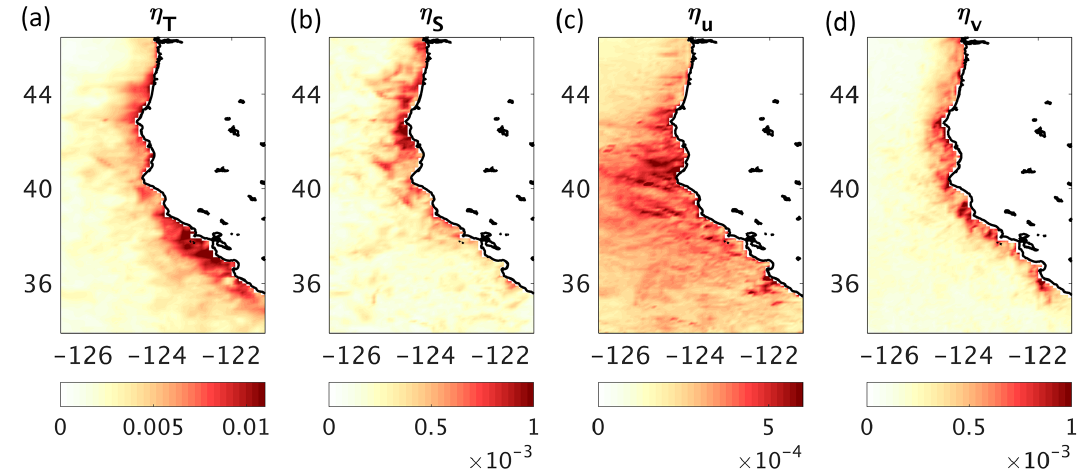
Figure 15. The rms corrections η made by weak constraint 4D-Var per time step during experiment BHM in 2005 for (a) SST, (b) SSS, (c) surface zonal velocity, and (d) surface meridional